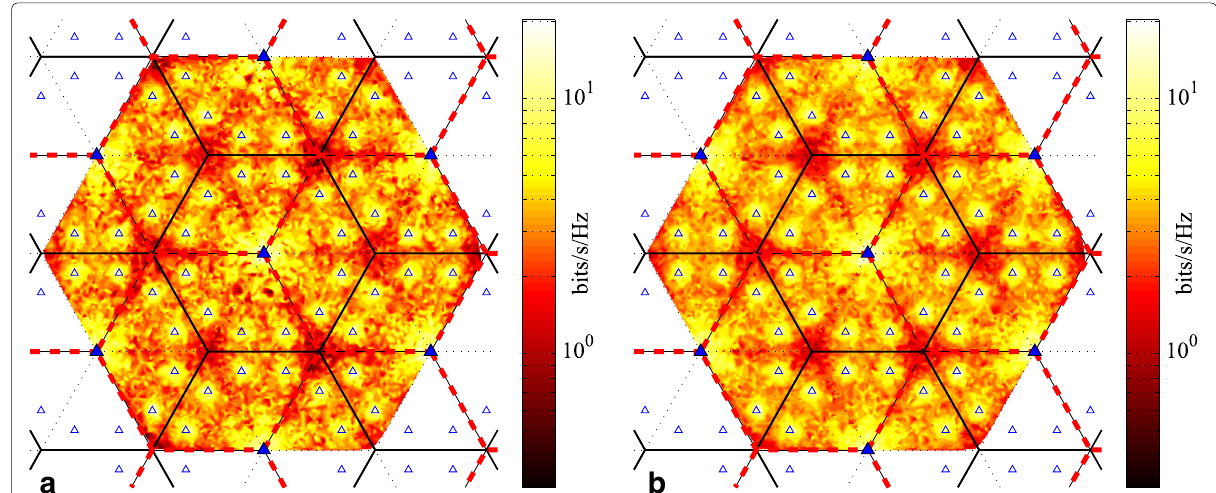
Fig. 8 Average achievable rate per user based on user position within cellular network, with PF scheduling metric for six-cell layout, using simulated annealing scheduling and SZF-DPC precoding; N macro = N pico = 2, M = 2, K c = 12. a Fixed clustering. b Rotating clustering ( T cl =